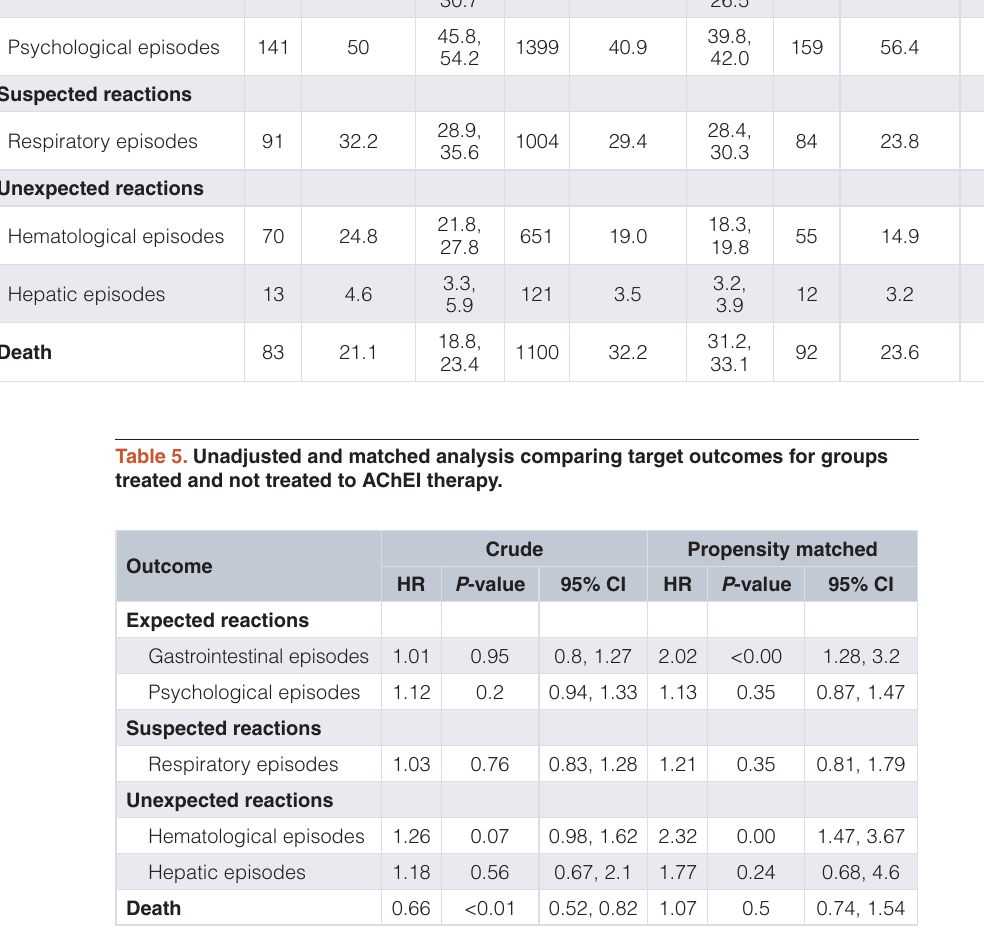
Table 4. Crude incidence densities (per 100-person years) of target events in AChEI treated and untreated groups. AChEI treated cohort Untreated cohort Matched untreated cohort Incidence N Density